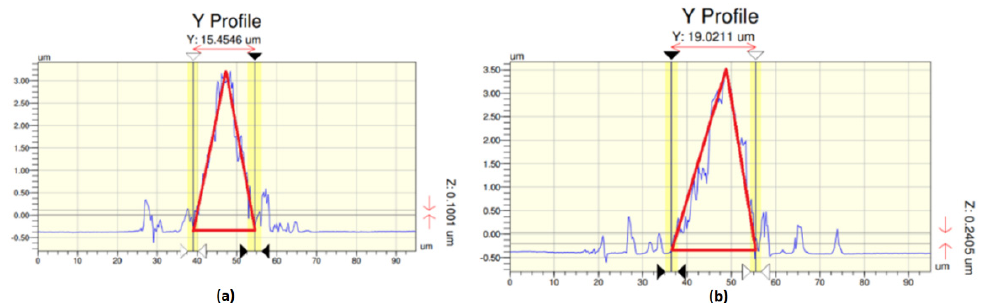
Figure 4. Examples of calculating cross-sectional area for samples printed with Clariant Prelect TPS50. Peaks outside of the triangles represent overspray. Cross-section at the beginning ( a ) and at the end ( b ) of the